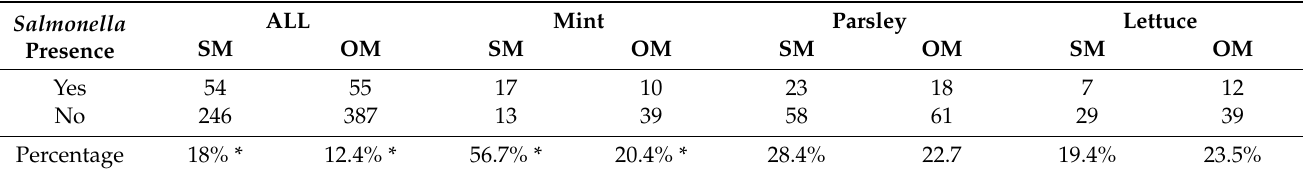
*, indicates statistically significant difference. Grey cases represent samples from supermarkets. Table 3. Contamination of vegetables from supermarkets and open markets. Salmonella